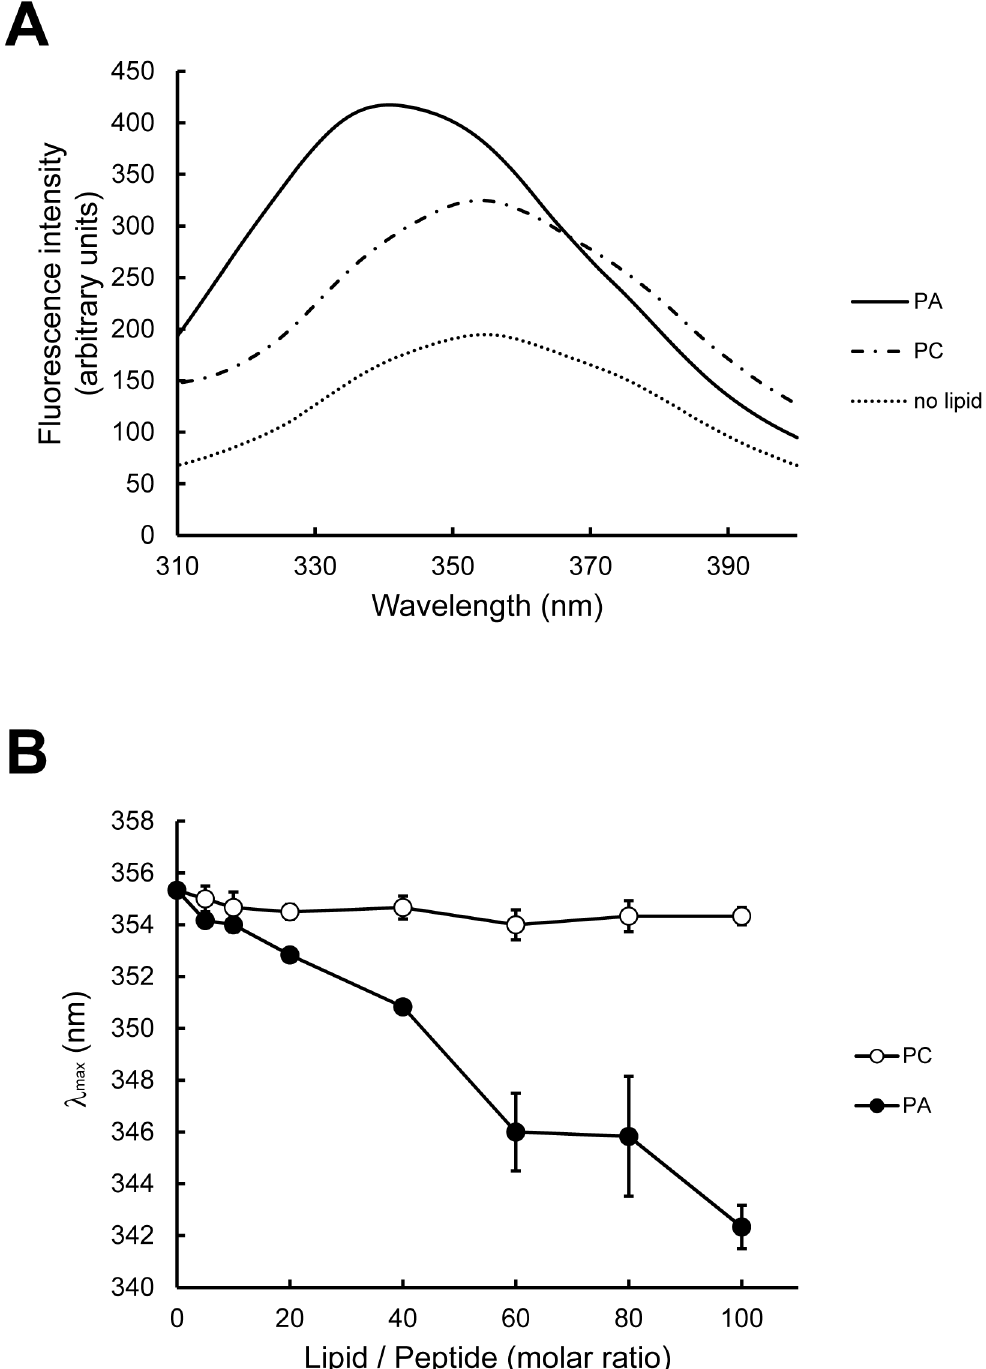
Fig 6. Fluorescence measurement of tryptophan residues. (A) PAB-TP was incubated with or without LUVs (160 μ M total lipids) composed of DOPA/ DOPC/cholesterol (10:60:30) and DOPC/cholesterol (70:30) for 1h at 25°C. Fluorescence spectra were obtained with the excitation wavelength at 280 nm. (B) PAB-TP was incubated with LUVs (0 – 160 μ M total lipids) composed of DOPA/DOPC/cholesterol (10:60:30) and DOPC/cholesterol (70:30) for 1h at 25°C. Fluorescence spectra were obtained with the excitation wavelength at 280 nm and the wavelength of maximum fluorescence ( λ max ) was plotted against the molar ratio of lipid to peptide. (mean ± SE, n =